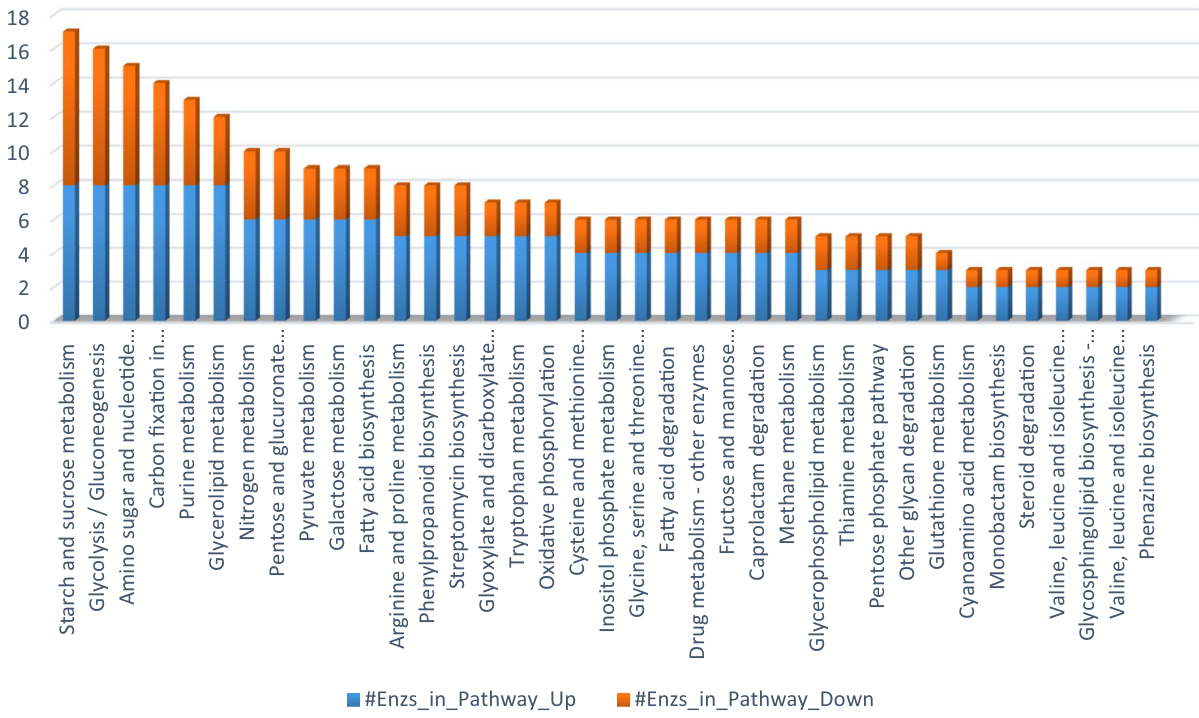
Figure 4. Different metabolic pathways and associated genes encoding enzymes that participated in different metabolic pathways.